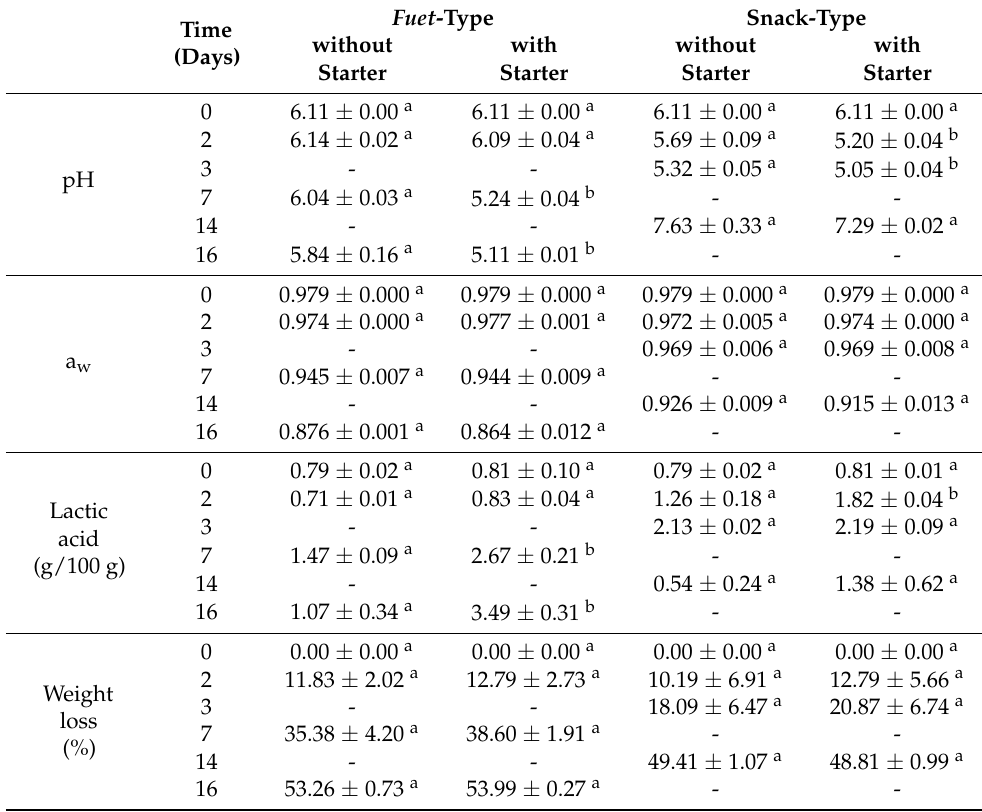
Table 1. Results of physicochemical determinations during the production process of fuet and snack-type DFS. Results are expressed as mean ± standard deviation of three